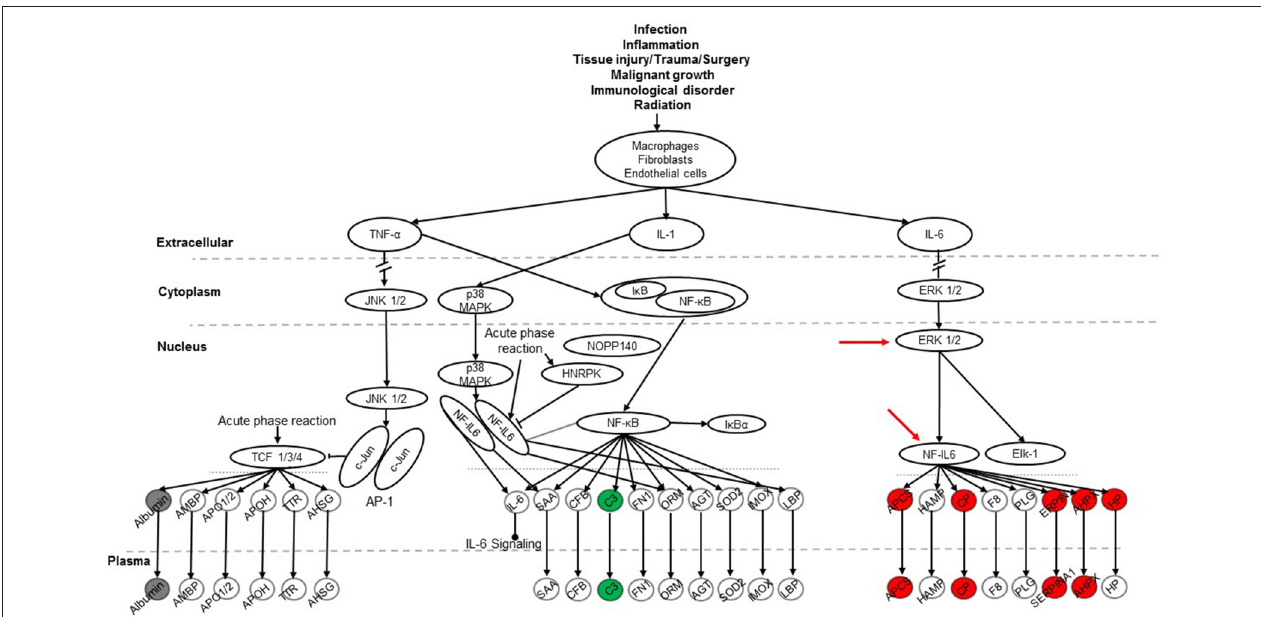
FIGURE 7 | The APR signaling pathway is associated with ozone exposure and bacterial infection. A total of 36 proteins were identified in this study and were used for Ingenuity Pathway Analysis. The canonical “APR signaling” pathway was found to be associated with these proteins ( p < 4.17E-11). An example of the comparison among SP-A genotypes is shown for the SP-A2M_FA vs. KOM_FA comparison where proteins with increases in ( > 25%) expression are shown in red, proteins with decreases ( > -25%) are shown in green, and proteins with changes < 25% are shown in gray. ERK1/2 and NF-IL6 in the pathway are indicated with red arrows.